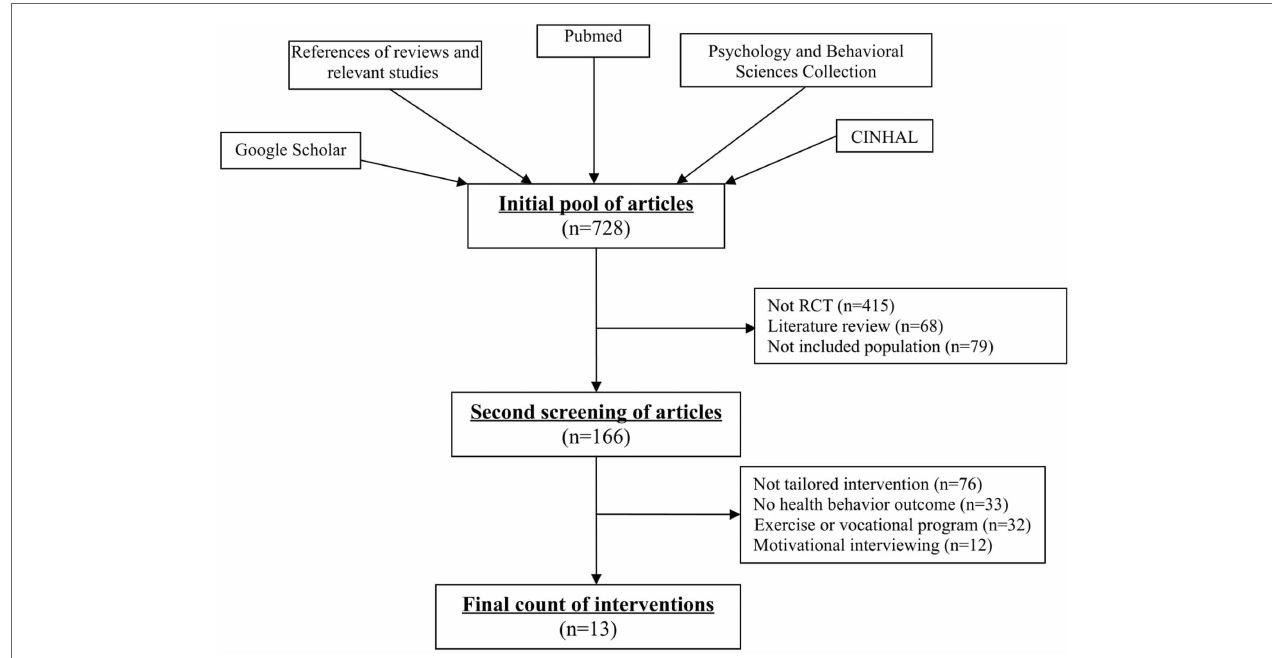
FiGURe 1 | Flow of articles through the study